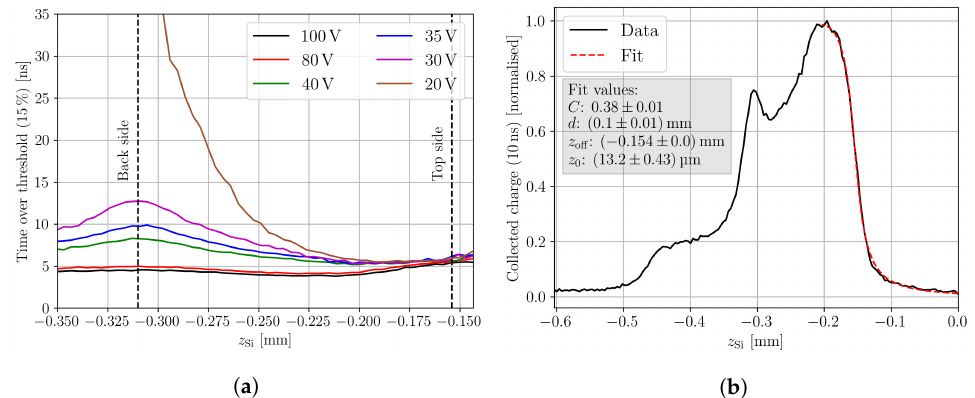
Figure 5. Figure ( a ) shows the time over threshold against the device depth for different bias voltages and a stage y = 0.07mm (compare to Figure 4). A total of 15% of the induced current signal’s maximum is used as a threshold. The top and back surface position are indicated by the dashed lines. The position of the back surface is extracted from the time over threshold profiles, and the position of the top surface is extracted from a fit towards the charge collection profile shown in Figure ( b ). The scan is performed at the same stage y = 0.07mm, and a bias voltage of 100V is used. The fit is performed according to Equation (6) towards the top side. Note that the depletion depth d is not properly fitted because only the rising edge is fitted. Due to clipping, the rest of the charge profile is not used for the